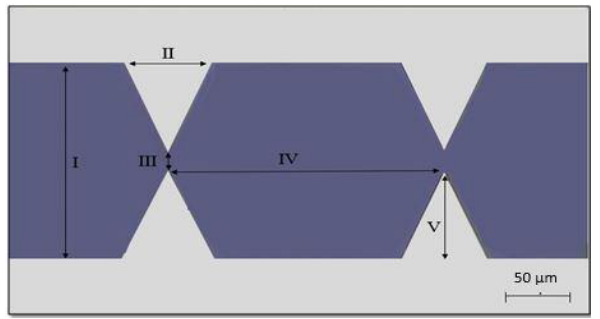
Figure 7. Dimensions of castellated microtip microelectrodes: (I) base to base = 300 µ m, (II) base of the electrode = 100 µ m, (III) spacing gap = 40 µ m, (IV) tip to tip = 300 µ m, and (V) the height of the electrode = 130 µ m.